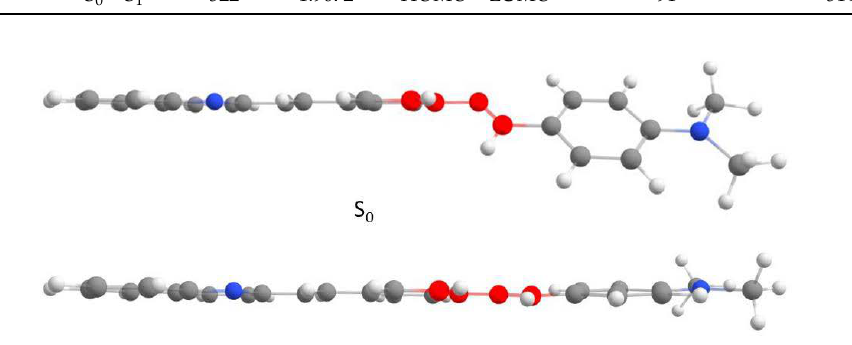
Figure 7. Visualization of the molecular orbitals that were involved in the main electronic transitions.